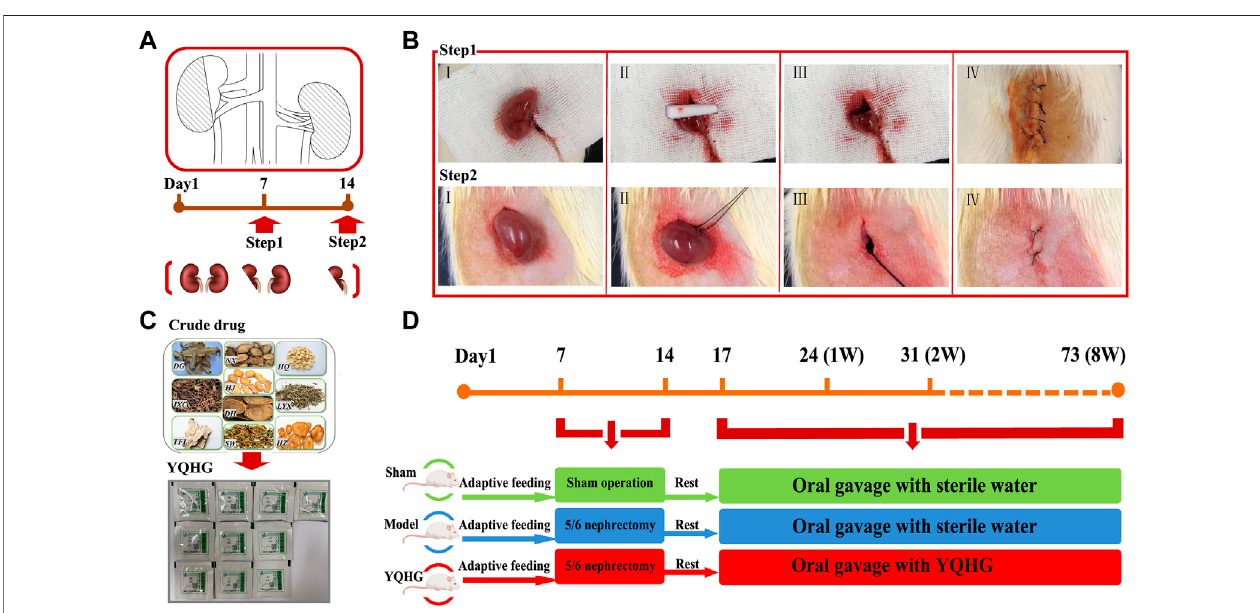
FIGURE 1 | The 5/6 nephrectomy and drug intervention regimen. (A) Pattern diagram of 5/6 nephrectomy. (B) Surgical diagram of 5/6 nephrectomy. Step1: ablated2/3 ofthe leftkidney. Ⅰ Exposedthe leftkidney. Ⅱ Removed 2/3 ofthe left kidney and compressed thewound withgelatinsponge to stopbleeding. Ⅲ Con fi rmed thatthere wasnobleedingonthecutsurface,and thenput theresidual kidneyintotheabdominal cavity. Ⅳ Suturedthemusclelayerandskinlayerbylayer,and applied iodophor for disinfection. Step2: nephrectomy of the right kidney. Ⅰ Exposed the right kidney. Ⅱ Ligation of renal pedicle with a sterile 3 – 0 suture. Ⅲ Removal of the right kidney. Ⅳ Sutured the muscle layer and skin layer by layer, and applied iodophor for disinfection. (C) Ten single granules of YQHG. (D) Time axis of model construction and drug intervention.